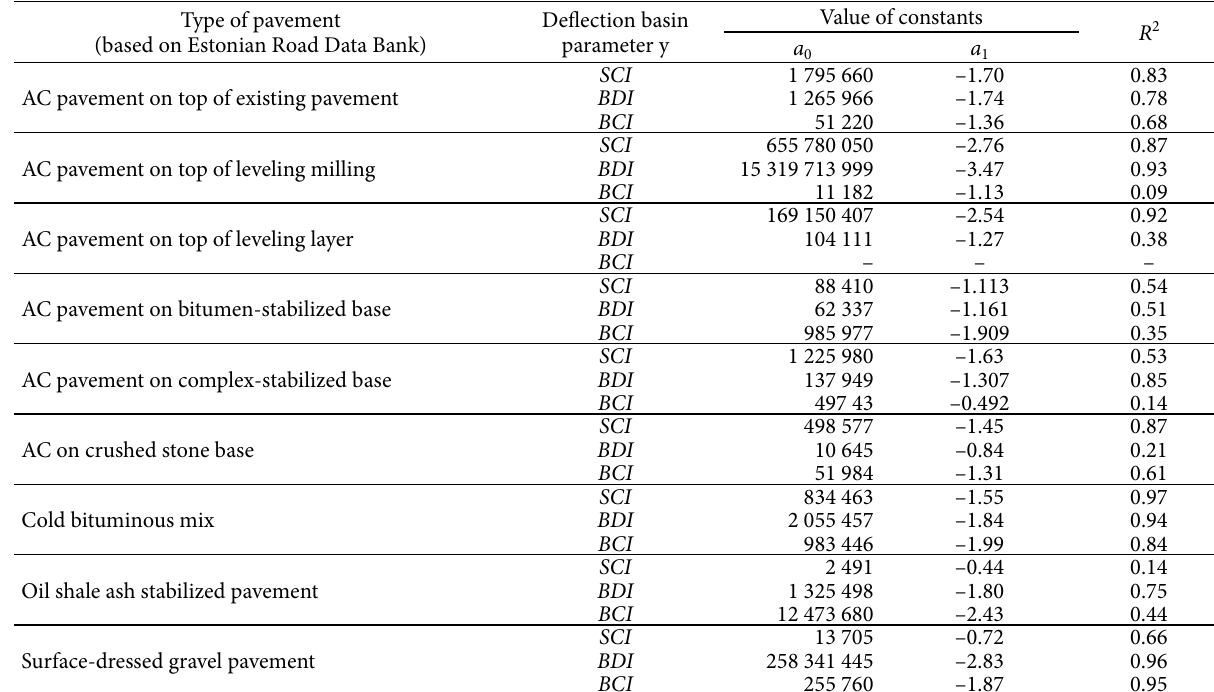
Table 5. Values of constants a 0 and a 1 in Eq (6) for calculation of the max allowable deflection basin parameter ( SCI, BDI, BCI ) values (Talvik 2007) Type of pavement (based on Estonian Road Data Bank)